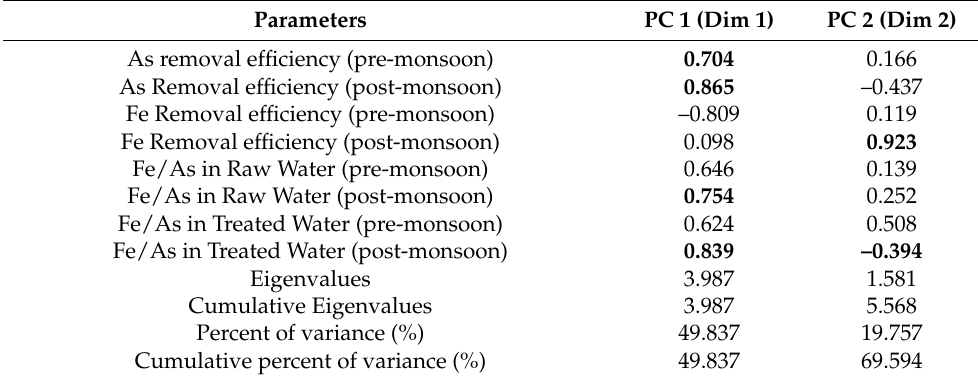
Table 2. Results of principal component analysis